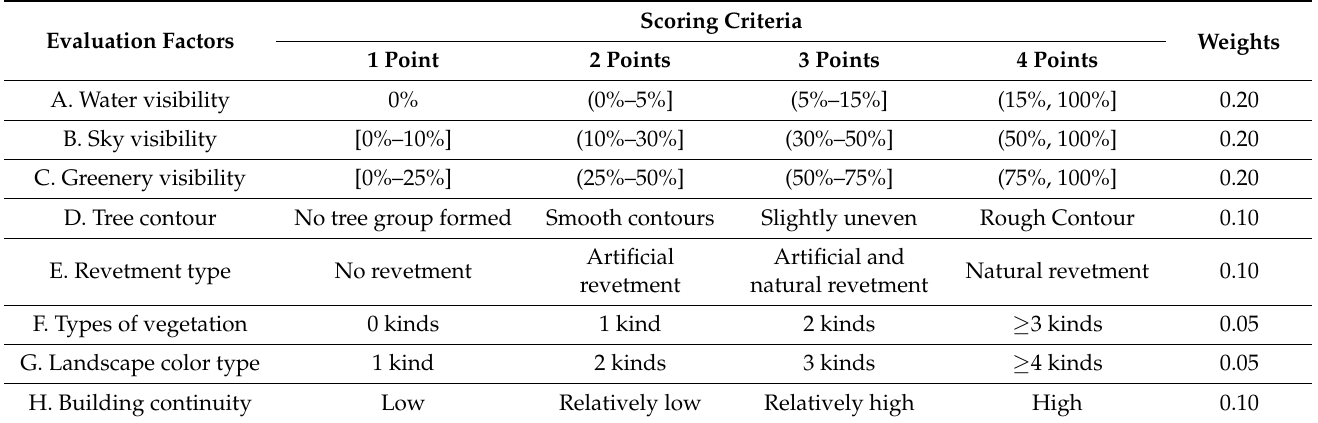
Table 4. Evaluation standard for space quality of the lakefront area.